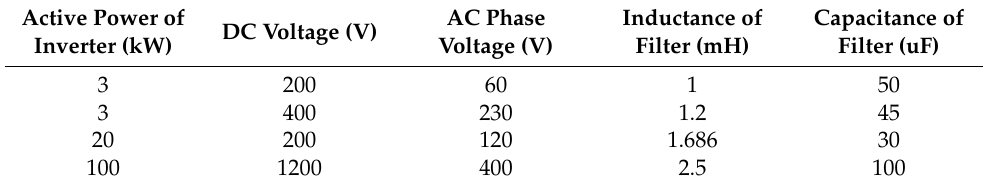
Table A1. Filter parameters in low-voltage